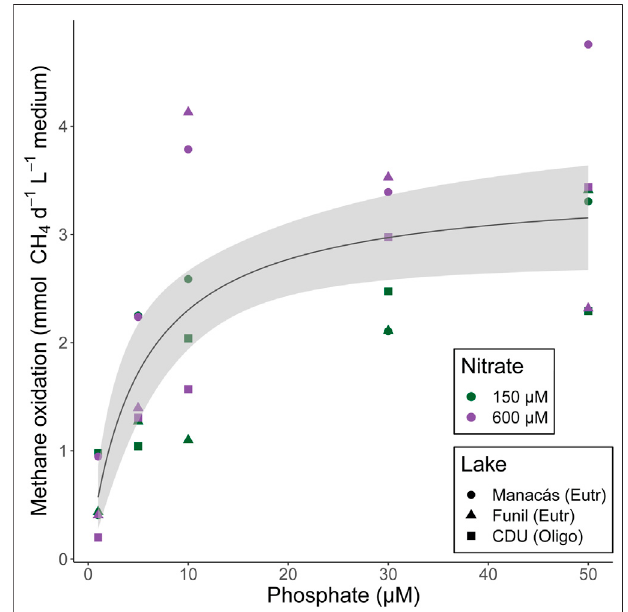
FIGURE 2 | CH 4 oxidation per day per ml of medium at different [PO 43- ] and[NO 3 − ]duringexponentialgrowthphaseofMOBfromManacáslake,Funil lake, and CDU lake. Fitted line according to nonlinear least-squares regression, shading represents 95% con fi dence interval. Individual measurements are shown, colours represent [NO 3 − ] treatments, shapes represent lake of origin, n = 30.